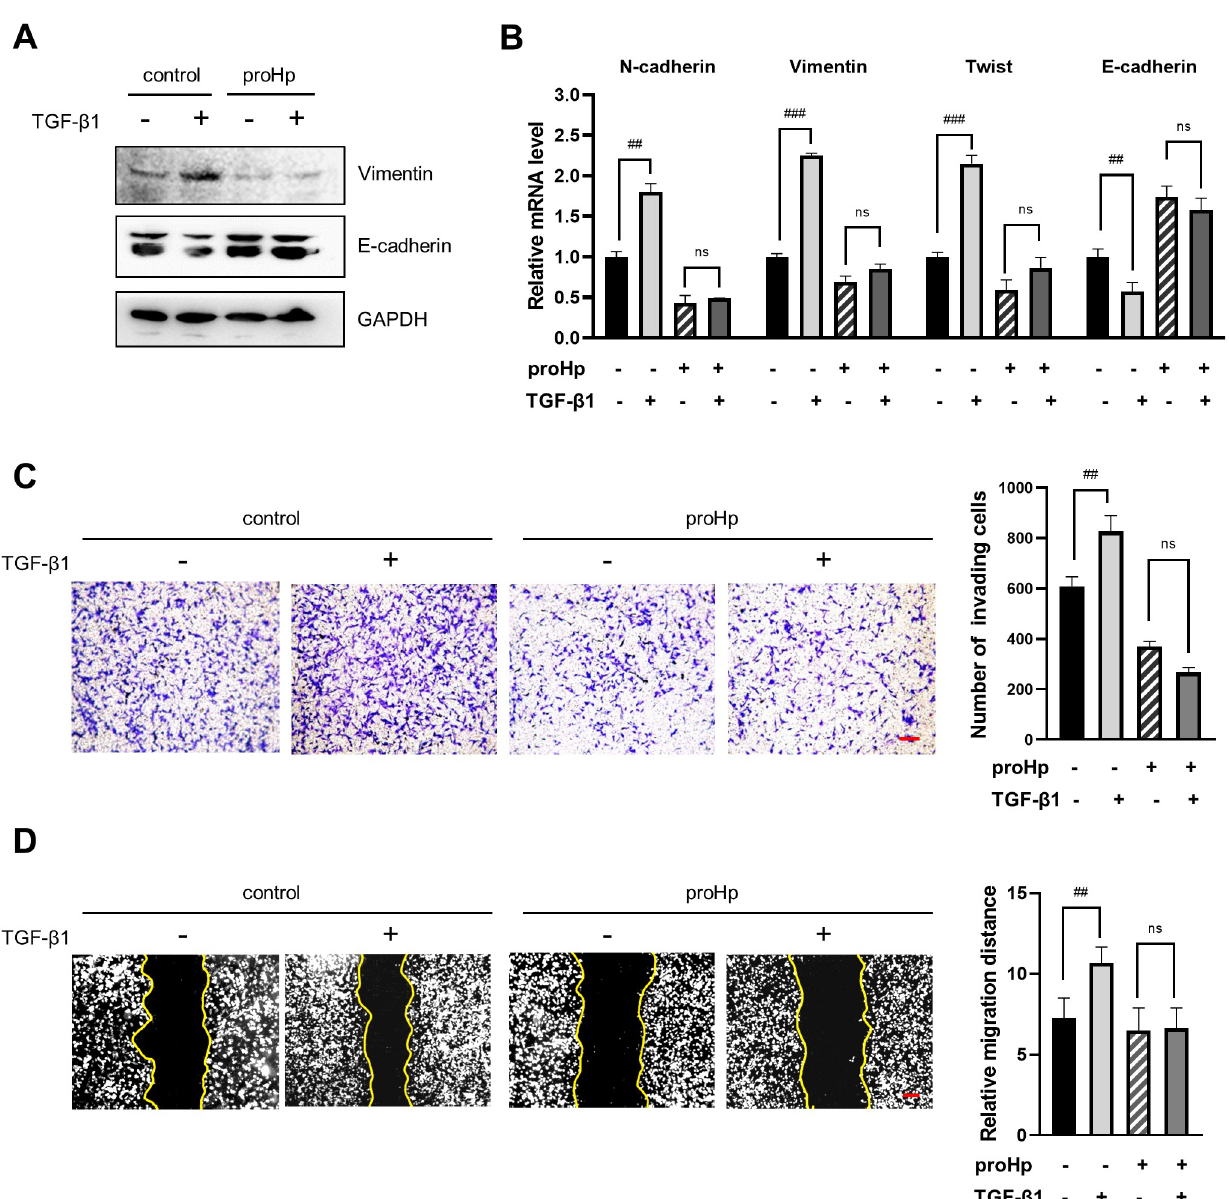
Fig 3. proHp attenuates the TGF- β -induced EMT. Control and proHp-overexpressing cells were treated with 5 ng/mL TGF- β for 48 h. (A) Expression of vimentin and E-cadherin in cell lysates was detected by Western blotting. (B) The mRNA levels of N-cadherin, vimentin, twist, and E-cadherin were determined by qRT-PCR and shown as relative levels. (C) Cells in serum-free media containing or lacking 5 ng/mL TGF- β were seeded in the upper chamber of transwell inserts and 10% FBS-containing DMEM was added to the lower chamber. After incubation for 24 h, invading cells were photographed under a microscope (scale bar = 100 μ m) and counted in three randomly selected fields per group. (D) Wound healing assays were performed in medium lacking or containing 5 ng/mL TGF- β . After culture for 24 h, cell migration was observed under a microscope and the migration distances were quantified at 14 random sites in the captured images using ImageJ software. All quantitative results are presented as the mean ± SD of triplicate experiments. ## P < 0.01, ### P < 0.001 vs. no TGF- β treatment. “ns” means not significant ( P > 0.05 vs. TGF- β -untreated proHp-overexpressing cells, Student’s t-test). All figures are representative of independent experiments performed at least